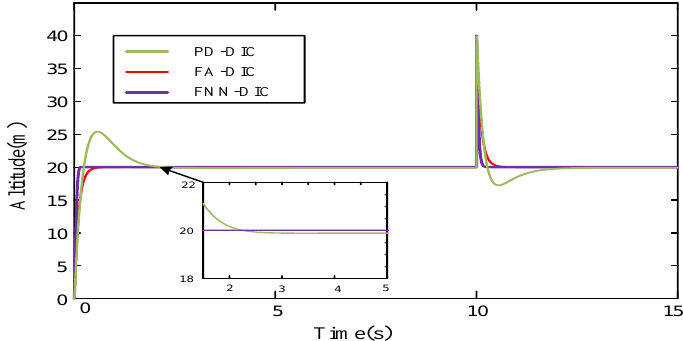
Figure 6. Experimental results of three controllers on altitude channel.